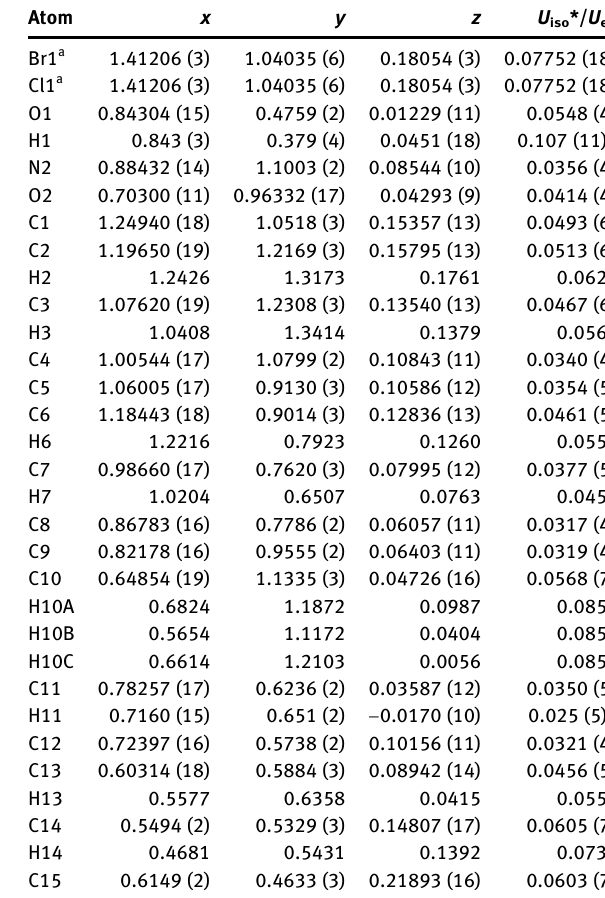
Table  : Fractional atomic coordinates and isotropic or equivalent isotropic displacement parameters (Å 